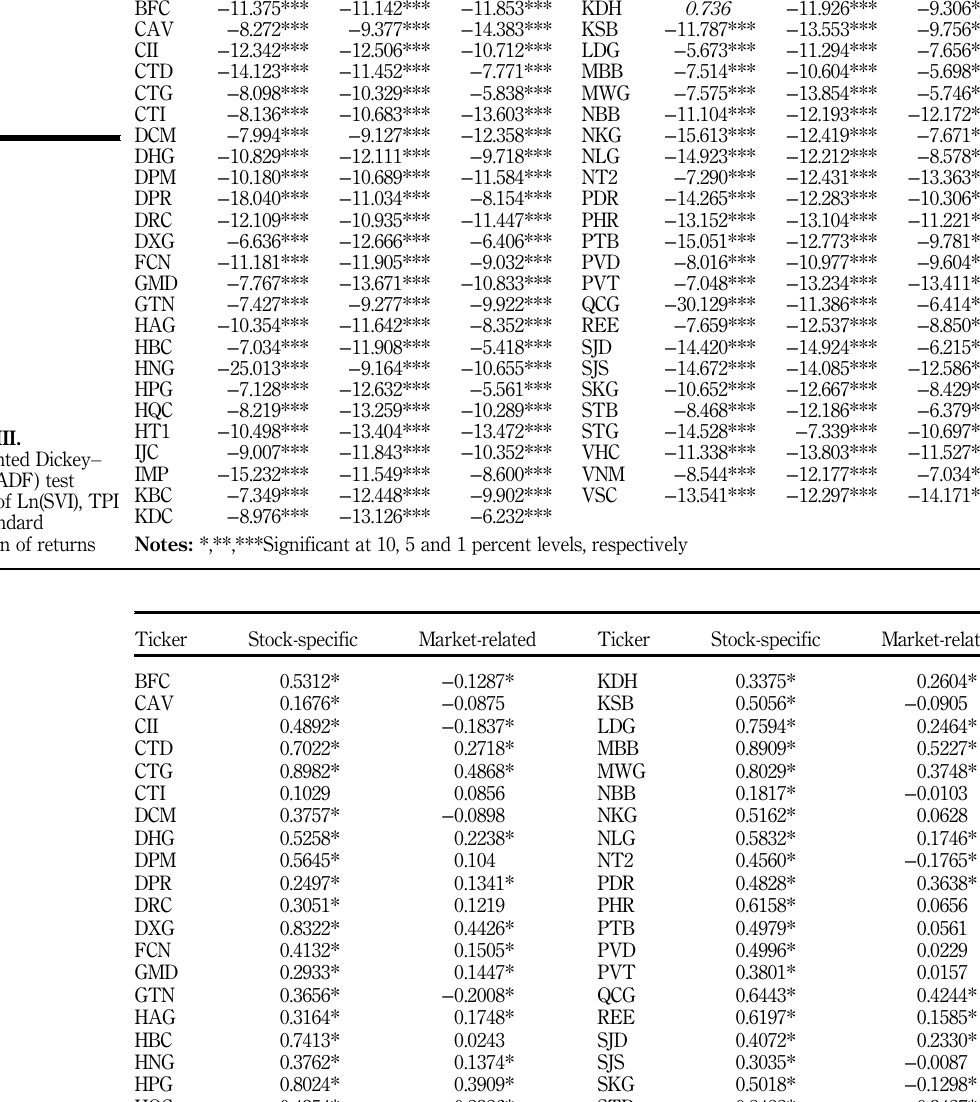
Table IV. Correlation between weekly stock-specific and market-related SVI to trading volume in the same